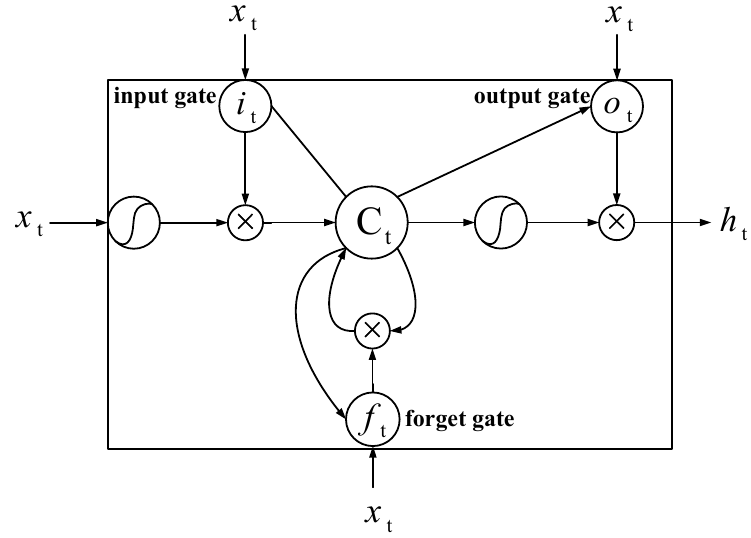
Figure 4. A Long Short-Term Memory Cell.